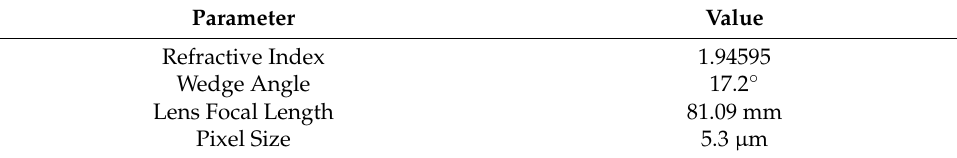
Table 1. System parameters used in